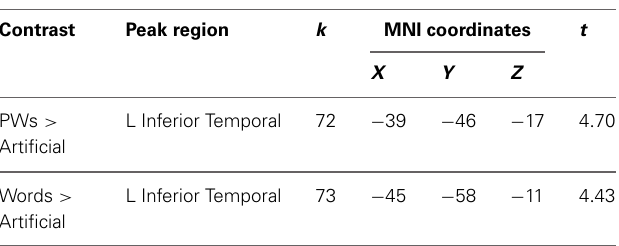
Table 3 | Auditory stimuli: Brain regions showing positive word-likeness